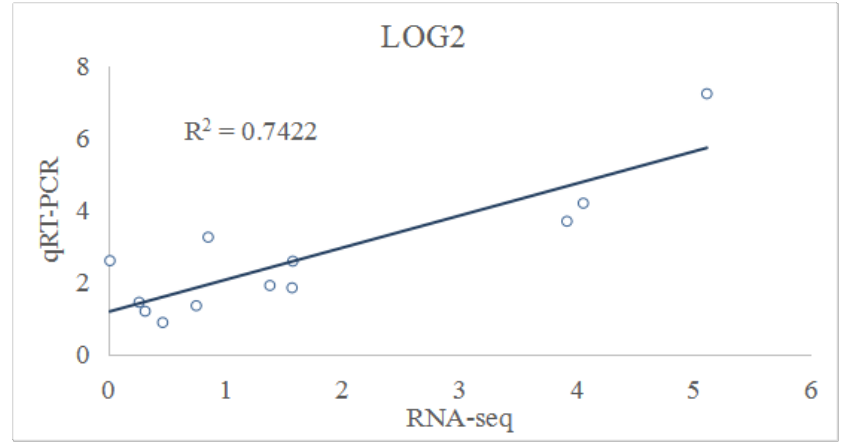
Figure 4. Expression analysis of selected DEGs, using qRT-PCR.